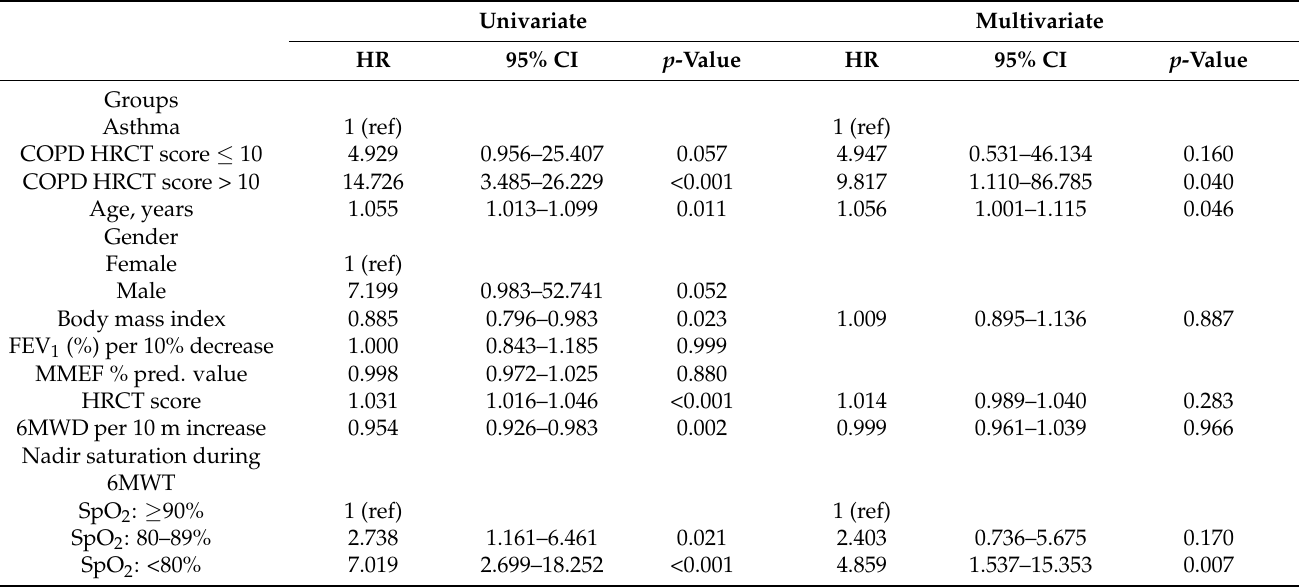
Figure 5. Kaplan–Meier survival curves for matched asthma and COPD with or without emphysema cohort for five-year all-cause mortality. The p value is shown. Table 3. Factors associated with all-cause mortality at a five-year follow-up in a Cox regression model.